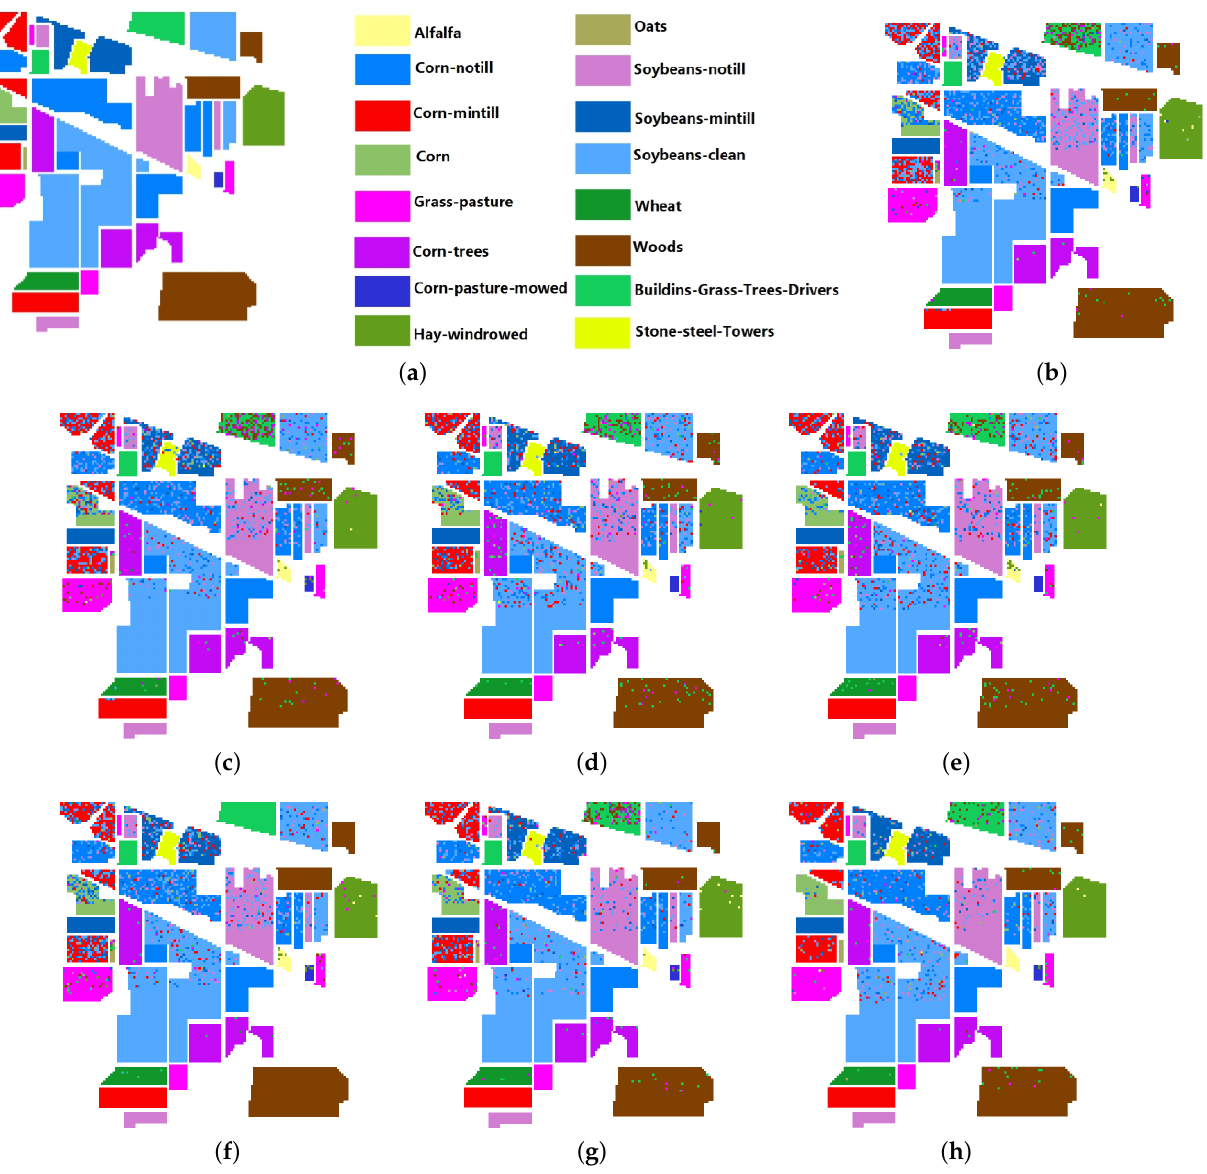
Figure 3. Ground truth (GT) and classification maps of SVM, RF, RoF, CNN, SMOTE-RoF, RBDF as well as the proposed SMOTE-WDRoF method on the hyperspectral data Indian Pines AVRIS . ( a ) GT. ( b ) SVM. ( c ) RF. ( d ) RoF. ( e ) SMOTE-RoF. ( f ) CNN. ( g ) RBDF. ( h )